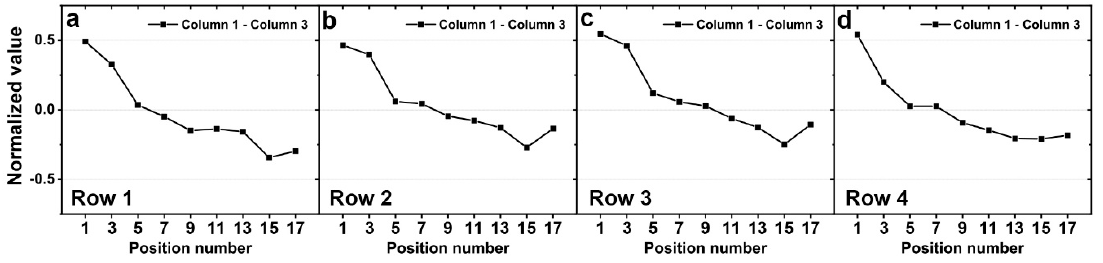
Figure 11. Simulation results of the difference between the normalized values for column 1 and 3 ( a ) when 5 N of force was applied to row 1, ( b ) when 5 N of force was applied to row 2, ( c ) when 5 N of force was applied to row 3, and ( d ) when 5 N of force was applied to row 4.